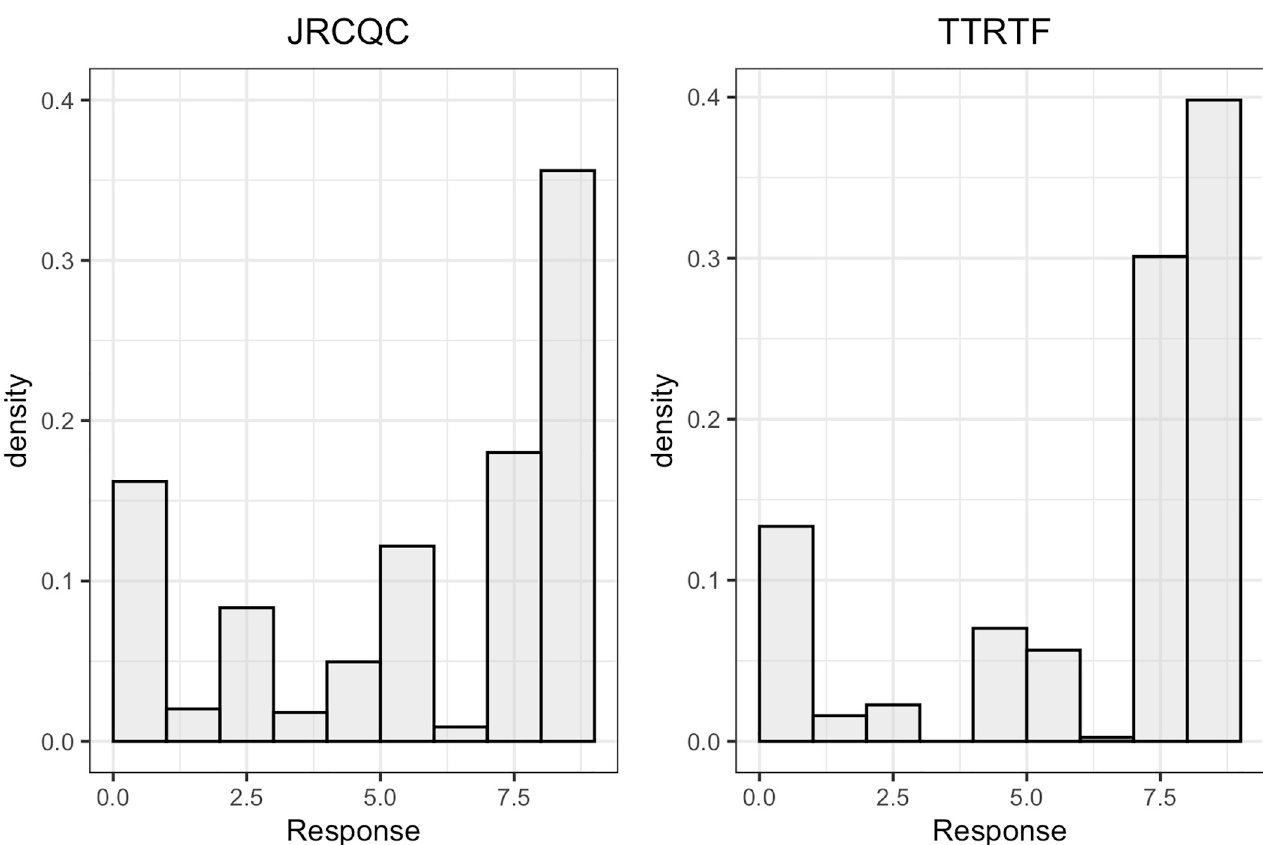
Fig 1. Distribution of seedling responses of the RIL population derived from ‘Reichenbachii’ /DAKIYE to races JRCQC and TTRTF.